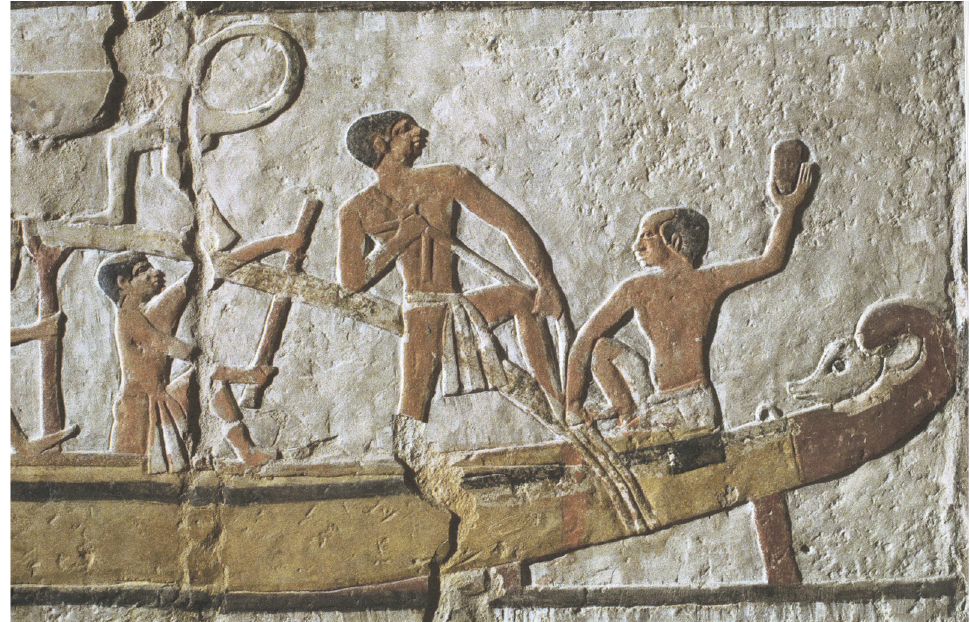
Figure 4. Rare scene detail of a hedgehog-head boat in a shipyard with craftsmen warping the hull. East wall of the 5th Dynasty tomb of Nefer and Kahay at Saqqara (Harpur and Scremin 2010, p. 169 [cf. 177]). Cropped detail adapted from photograph taken by Paolo Scremin. Image reproduced with permission of Yvonne Harpur, Oxford Expedition to Egypt.